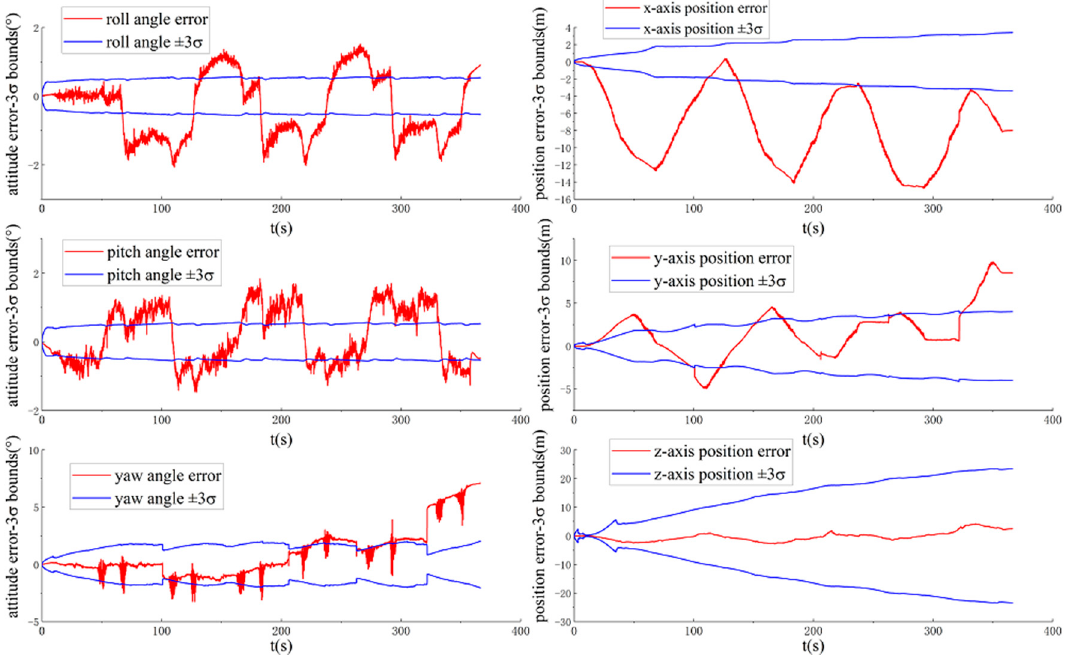
Figure 6. The ground-truth pose errors and estimated ± 3 σ bounds of ACK-MSCKF(3) with time for the VD06 dataset.